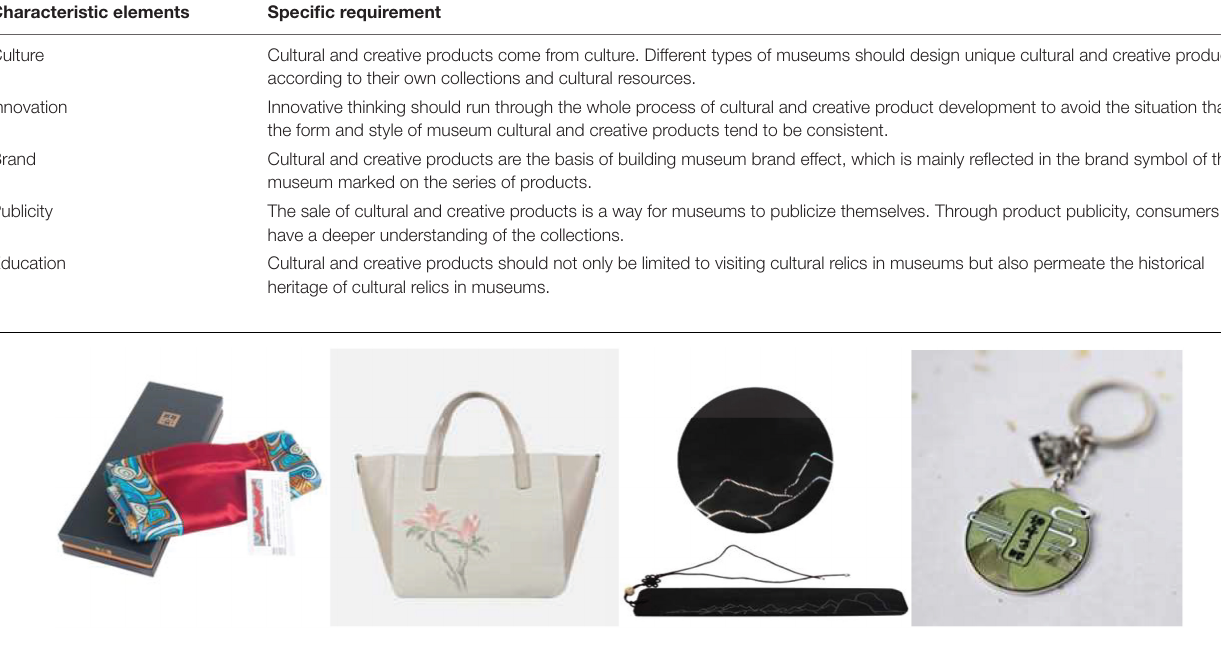
FIGURE 3 | Four series of cultural and creative products of Suzhou Museum. Images reproduced with permission from Suzhou Museum.